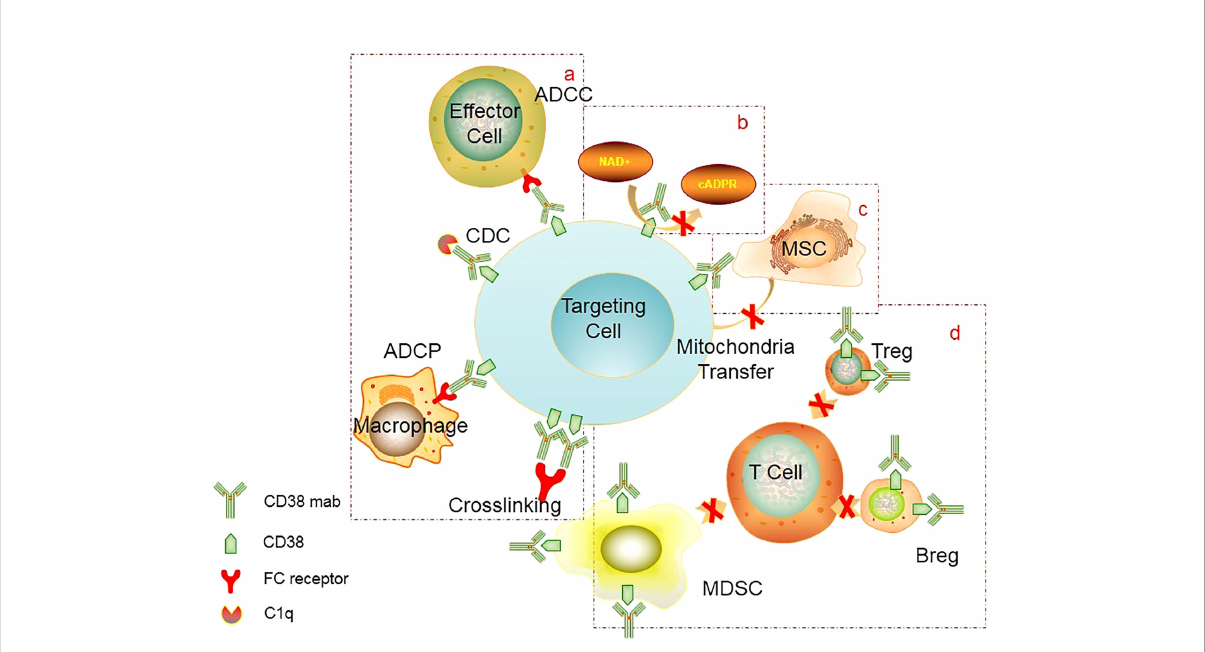
FIGURE 1 Mechanism of CD38 mAb: (A) FC-mediated ADCC, ADCP, cross-linking to induce apoptosis, CDC. (B) Inhibition of CD38 activity. CD38 mAb can block the catalytic activity of CD38 cyclase and hydrolase, thereby preventing calcium in fl ux and inhibiting cell signal transduction. (C) Inhibition of mitochondrial transfer. CD38 mAb can inhibit mitochondrial transfer from mesenchymal stem cells to AL cells, thereby reducing metabolic capacity of tumor cells and ultimately inhibiting tumor proliferation. (D) Inhibition of immunosuppressive cells. CD38 mAb can eliminate CD38+ regulatory cells (Treg, Breg, MDSC), which can promote the expansion of effector T cells and enhance the immune killing effect. ADCC, Antibody-dependent cell-mediated cytotoxicity; ADCP, Antibody-dependent cellular phagocytosis; CDC, complement-dependent cytotoxicity; MSC, mescenchymal stem cell; MDSC, myeloid-derived suppressor cells; Treg, regulatory T cells; Breg, regulatory B